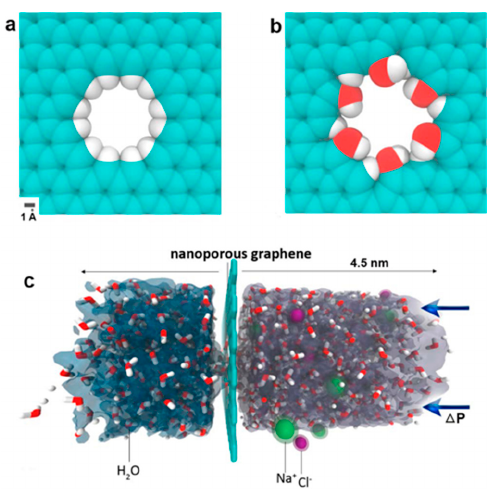
Figure 3. ( a ) Hydrogenated and ( b ) hydroxylated graphene pores; and ( c ) side view of